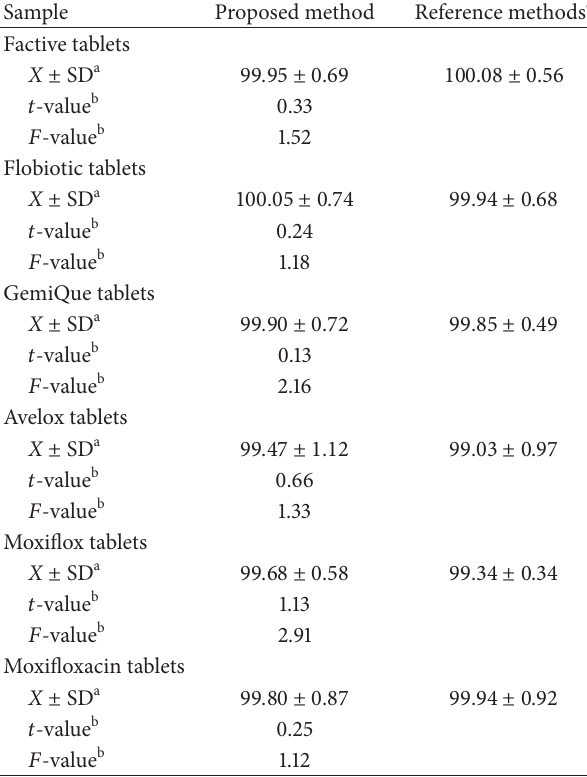
Table8:Applicationoftheproposedmethodsforthedetermination of GMF and MOX in their pharmaceutical preparations.